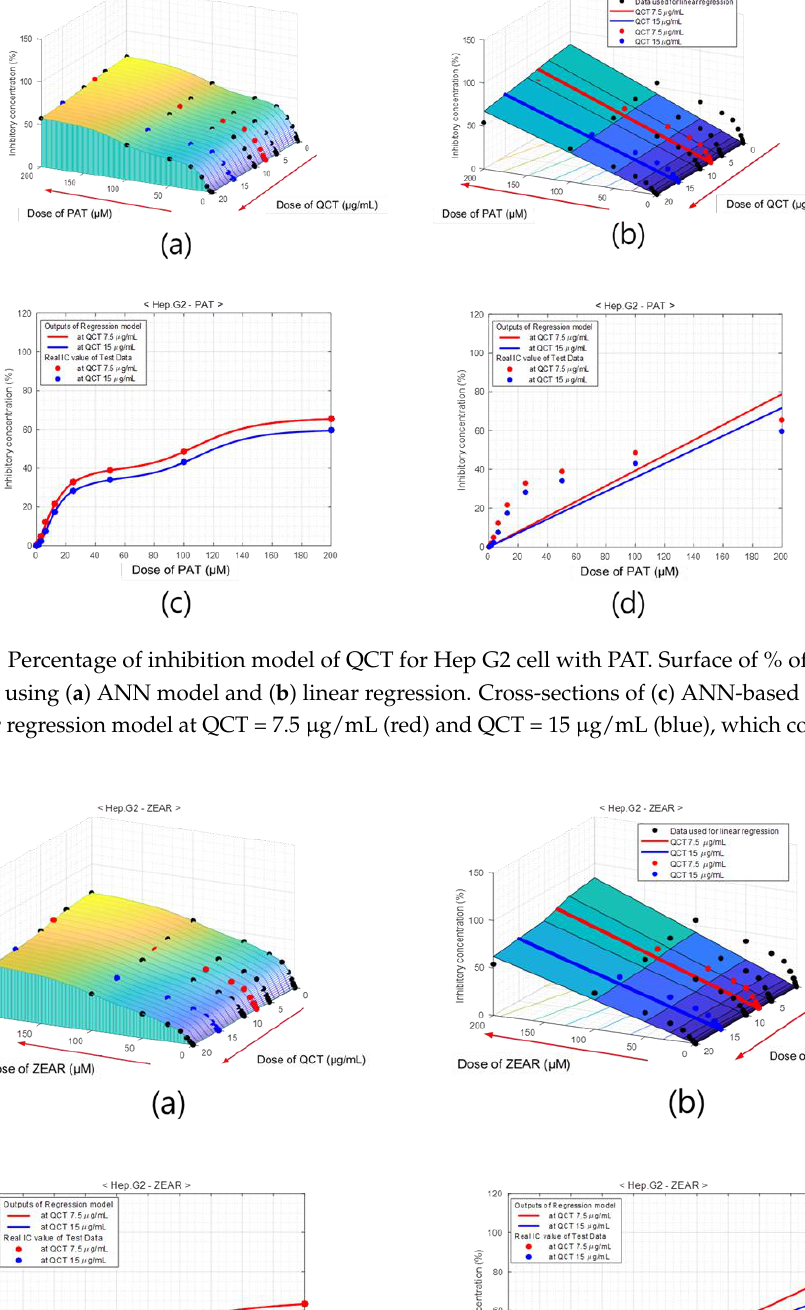
Figure 10. Comparison of error in modeling the % of inhibition on the test data using the partial least squares regression (PLS) and the artificial neural network method. Table 5. Performance comparison of a single hidden layer neural network by varying the number of nodes in the hidden layer. No. of Hidden Nodes